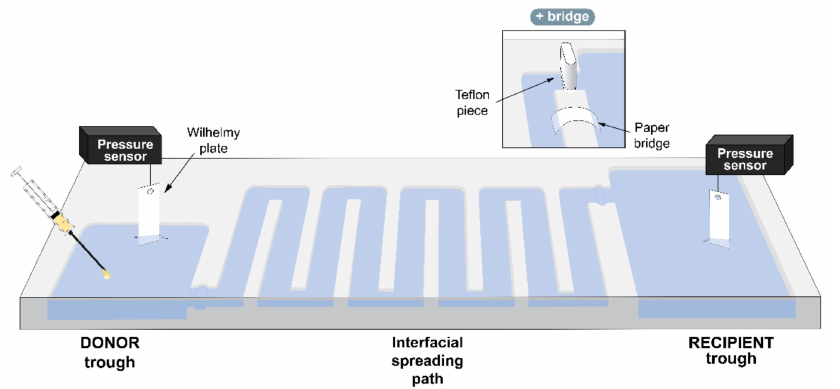
Figure 1. Schematic representation of the continuous double-balance setup. The vehiculization surface balance was designed and built on a stainless-steel plate. A donor compartment (24 cm 2 ) is connected to a recipient compartment (45 cm 2 ) by a long interfacial spreading path (90 cm, 75 cm 2 ). The material is injected into the donor trough, and its adsorption and spreading are monitored as it produces changes in surface pressure by two surface pressure sensors. Both troughs and the path can be isolated one from each other by Teflon pieces designed to be introduced into gaps dug at the entrance of the compartments. When necessary, the access to the recipient compartment can be closed by the Teflon piece and a hydrated paper bridge can be used instead to connect this trough with the path (represented in the upper square). The figure shows a top view of the balance, as well as a cross section to illustrate the depth of the different